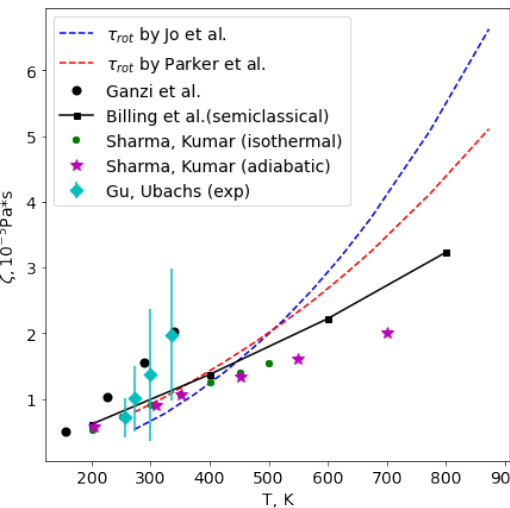
Figure 1. Bulk viscosity coefficient in N 2 as a function of T